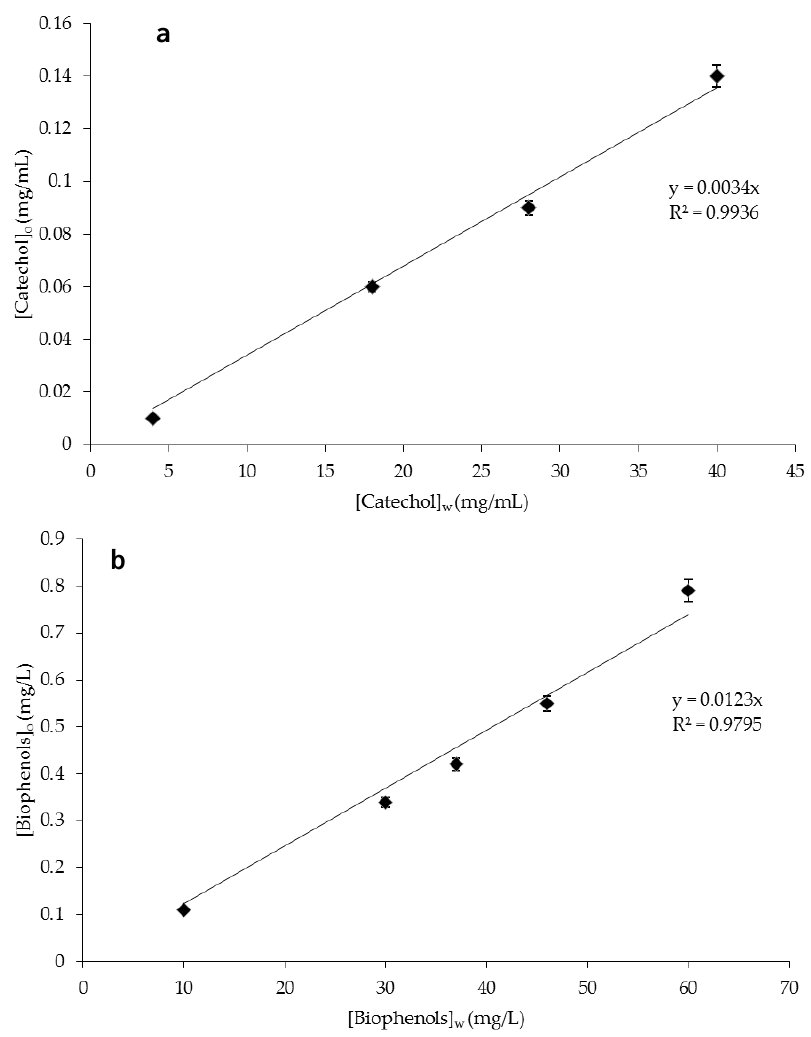
Figure 4. Extraction isotherm at 25 °C between aqueous and limonene phases of ( a ) catechol; ( b ) biophenols coming from olive mill wastewaters (OMWWs).